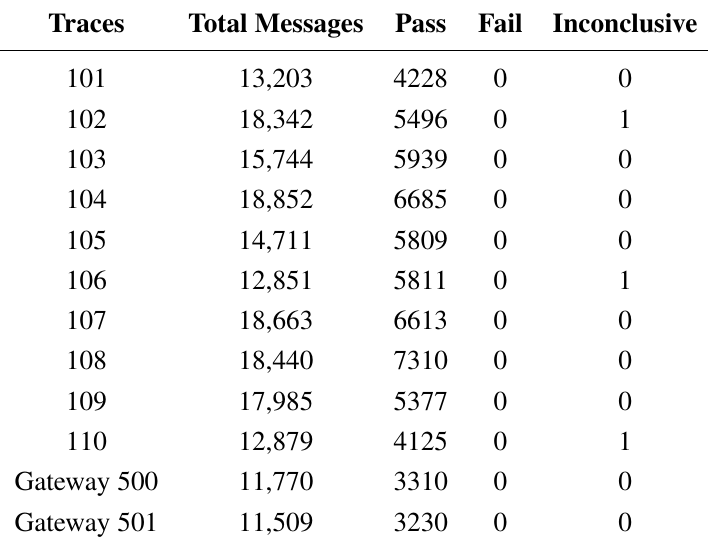
Table 3. Test results for Property 2 (Day 2).